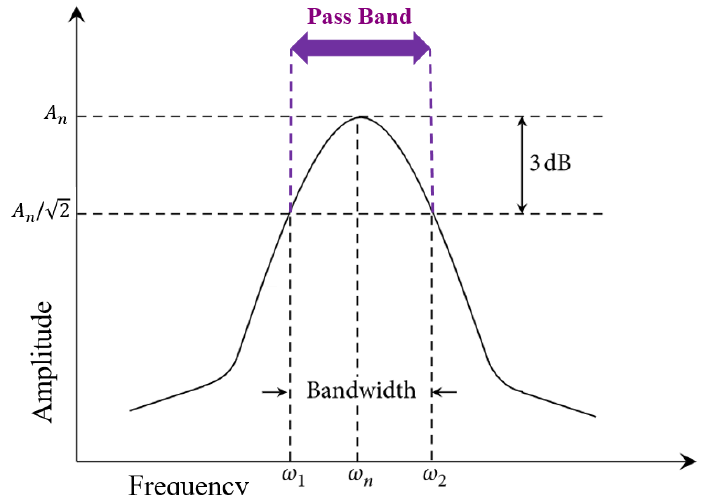
Figure 9. The 3 dB bandwidth indicator.